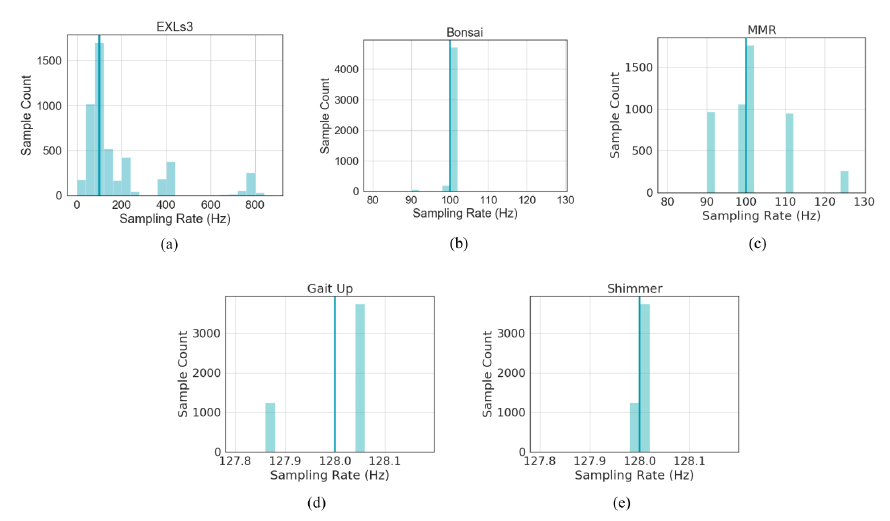
Figure 4. Sampling rates for ( a ) EXLs3 IMU, ( b ) Bonsai IMU, ( c ) MMR IMU, ( d ) Gait Up IMU, ( e ) Shimmer IMU. Sampling rates were calculated from timestamp intervals for the IMUs that provide timestamps. Configured sampling rates for the recording marked by a turquoise line.